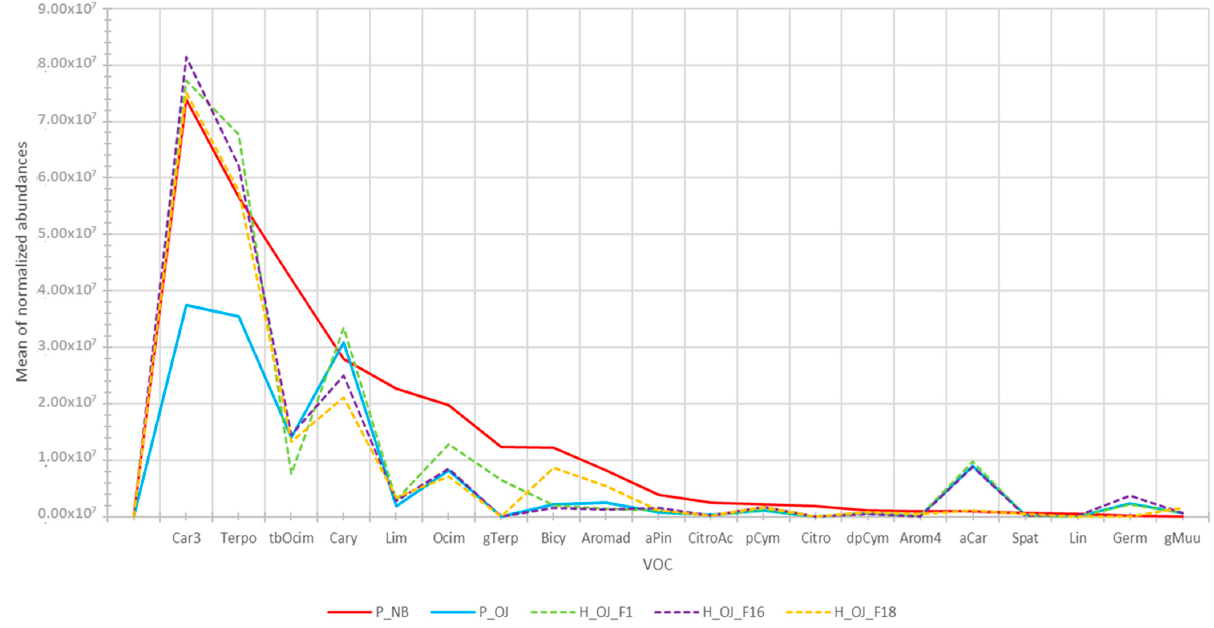
Figure 4. Profile in volatile compounds for Noir de Bourgogne (P_NB), OJ-5-3 (P_OJ), and three hybrid (H_OJ_F1, H_OJ_F16, and H_OJ_F18) plants from their crossings (mean values for three replications).